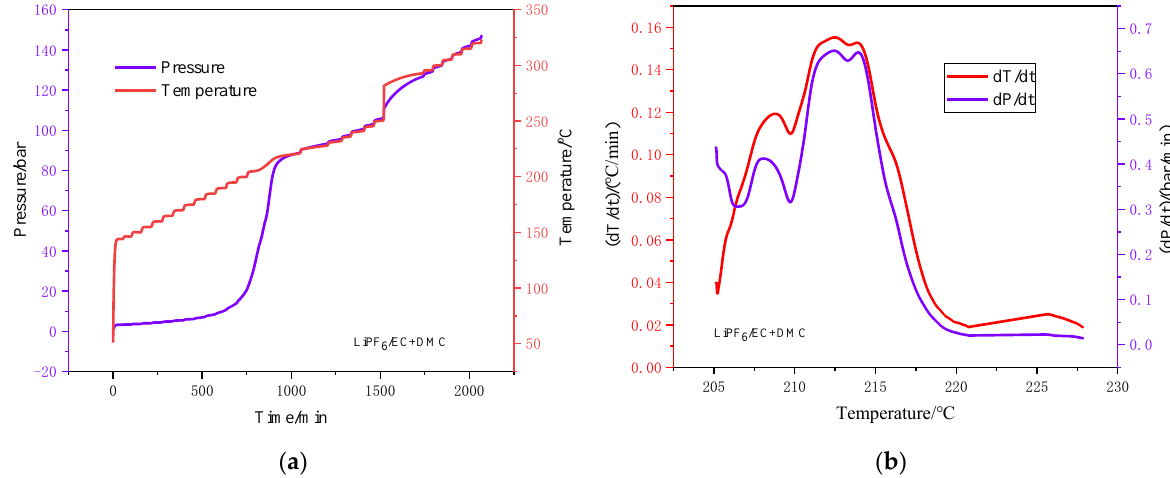
Figure 3. ARC curves of 1 M LiPF 6 /EC + DMC (2:3, v/v ). ( a ) Pressure and temperature versus time curves; ( b ) Self-temperature rise rate and self-pressure rise rate versus temperature curves.